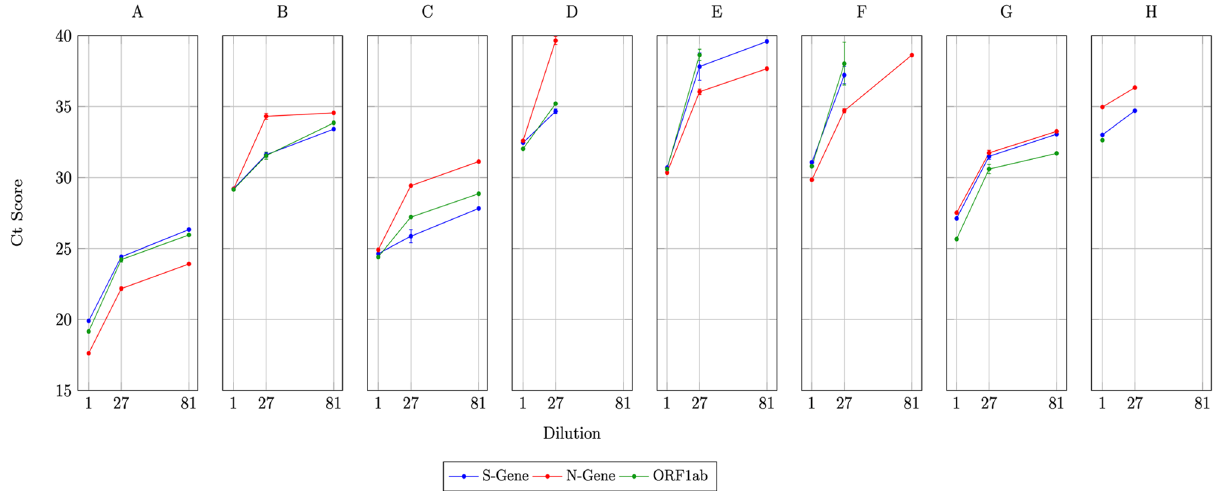
Figure 3. Detection of a single positive sample out of 81 for each of eight 4-d hypercube experiments ( A – H ). Ct scores are shown for: (a) the undiluted sample, (b) the mean and standard errors for the four positive slice pools which is diluted 27-fold, and (c) the hypercube pool in which the single positive is diluted